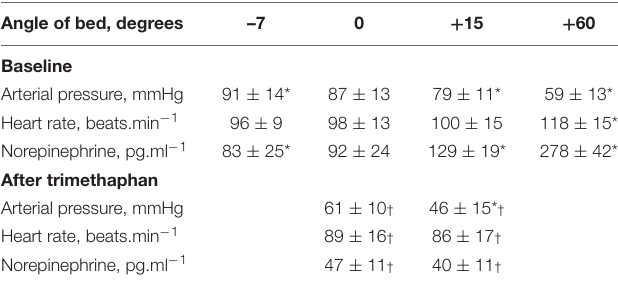
TABLE 1 | Effects of postural tilting on arterial pressure (AP), heart rate, and plasma norepinephrine level.